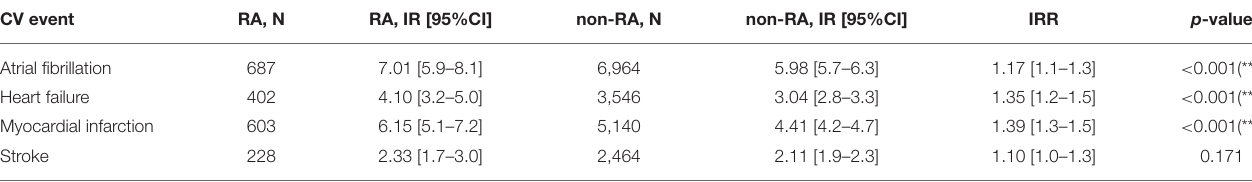
TABLE 1 | Incidence rates of cardiovascular (CV) events in the patients with and without RA (per year, per 1,000 person).